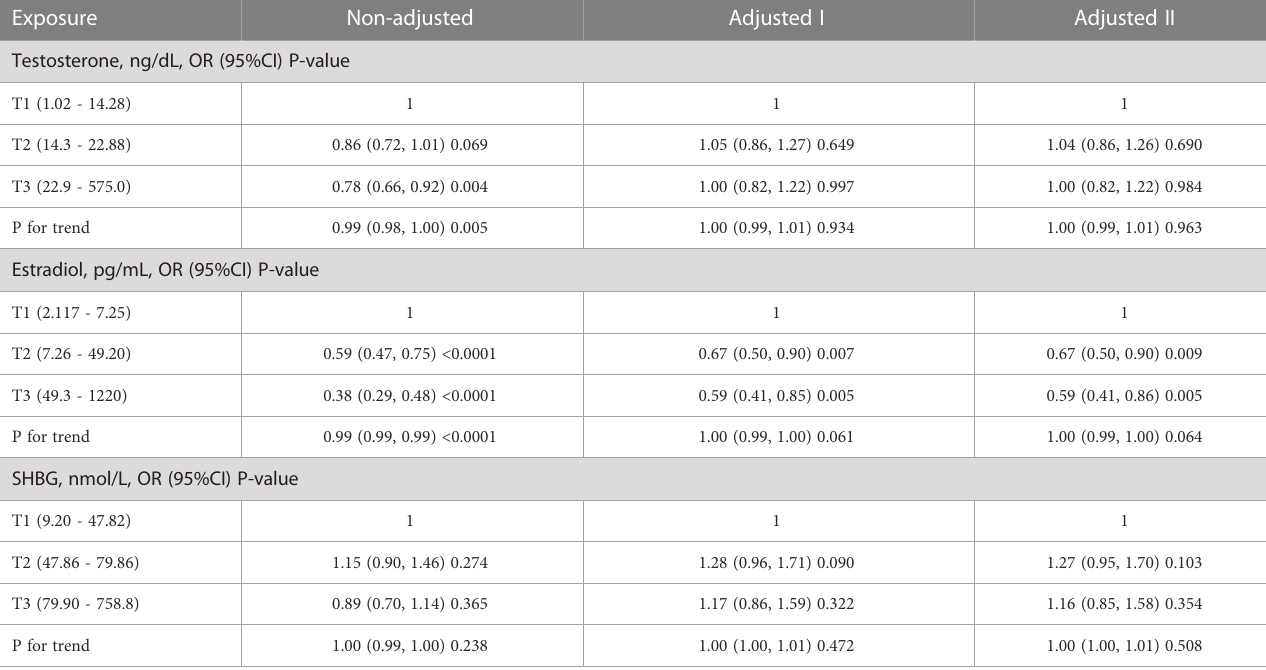
TABLE 3 The association of sex hormone levels sorted by tertile with periodontitis in